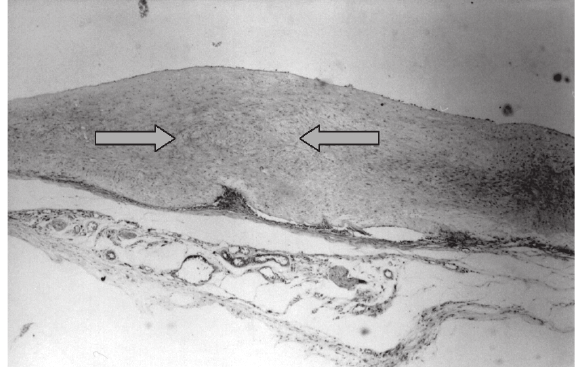
Fig. 7 - Fotomicrografia mostrando corte longitudinal da parede aórtica tratada com etanol 80%, apresentando calcificação difusa e moderada após 15 dias do implante. E 80% subgrupo 15 dias (von Kossa